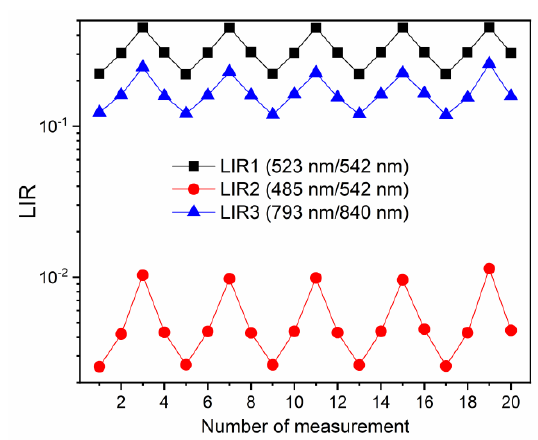
Figure 4. Repeatability of measurement tests of different LIRs (LIR1—black square symbols; LIR2—red circle symbols, LIR3—blue triangle symbols). The small variations in LIR values are within the value of uncertainty in measurements. The repeatability measurements were conducted at 313 K, 353 K, and 413 K.